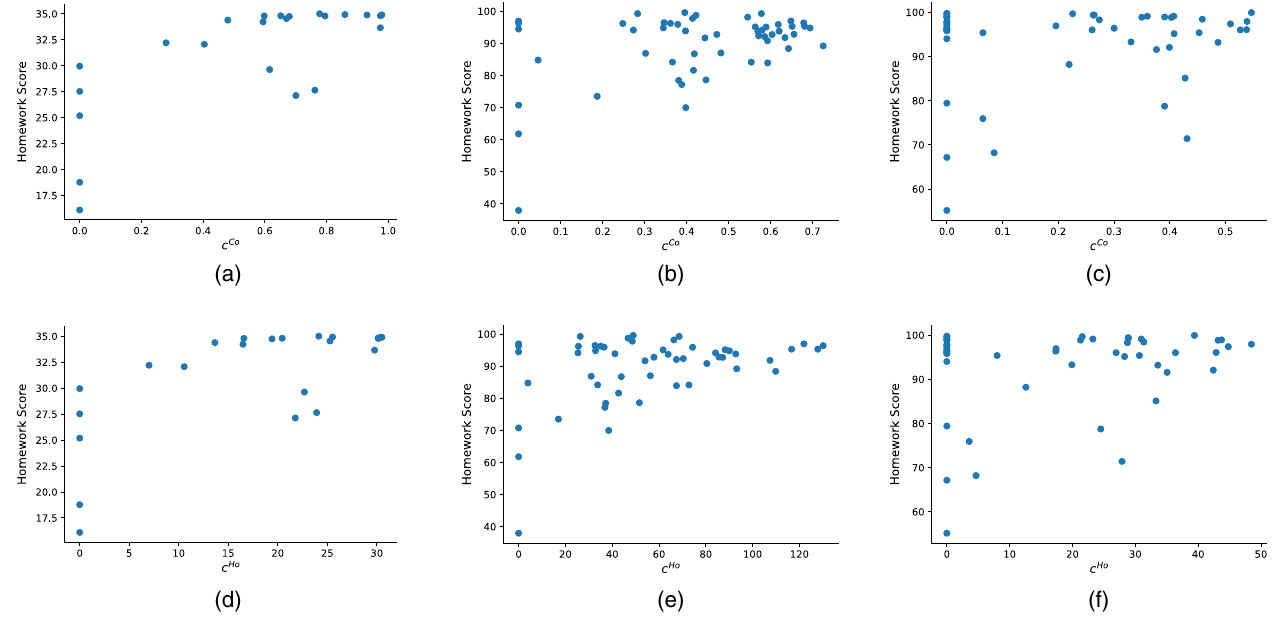
FIG. 11. Scatter plots of homework scores versus outward directed closeness and harmonic centrality. (a) Homework Score versus outward directed closeness centrality in the fall 2020 Mines course, (b) Homework score versus outward directed closeness centrality in the fall 2020 CU Boulder course, (c) Homework score versus outward directed closeness centrality in the spring 2021 CU Boulder course, (d) Homework score versus outward directed harmonic centrality in the fall 2020 Mines course, (e) Homework score versus outward directed harmonic centrality in the fall 2020 CU Boulder course, and (f) Homework score versus outward directed harmonic centrality in the spring 2021 CU Boulder